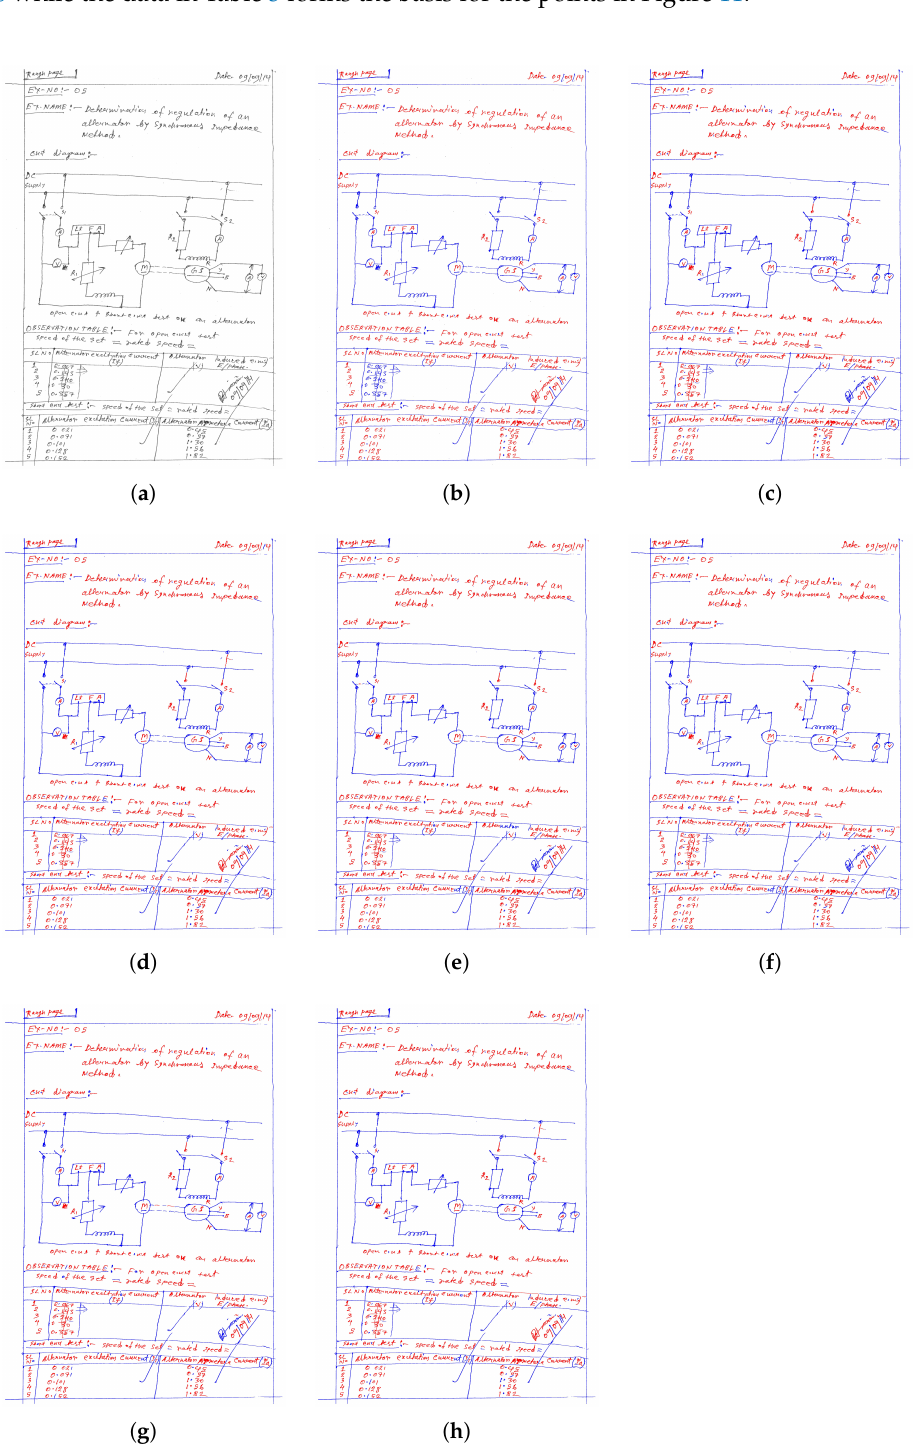
Figure 8. Pictorial comparison between the performances of different LBP based features with RF Classifier. Here, ( a ) grayscale image, ( b ) ground truth image, ( c ) result using LBP, ( d ) result using ILBP, ( e ) result using RILBP, ( f ) result using ULBP, ( g ) result using RIULBP, and ( h ) result using